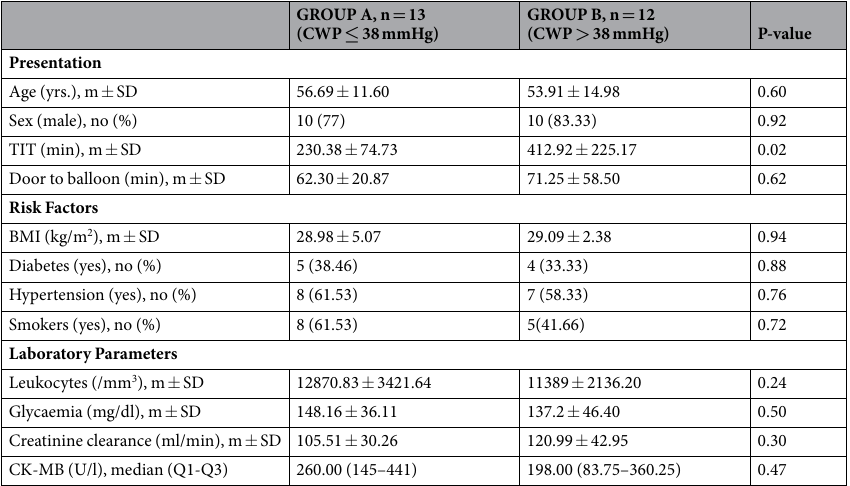
Table 1. Clinical and laboratory characteristics of the two groups. BMI = body mass index; CK-MB = creatine- kinase myocardial band; CWP = coronary wedge pressure; m = mean; Q1 = first quartile; Q3 = third quartile; SD = standard deviation; TIT = total ischemic time.